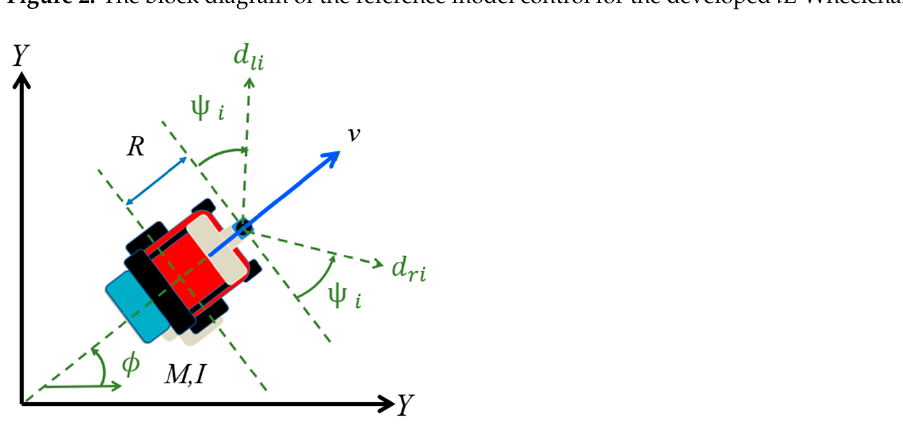
Figure 3. A cartoon representation of our i E-Wheelchair with the differential-drive kinematics.